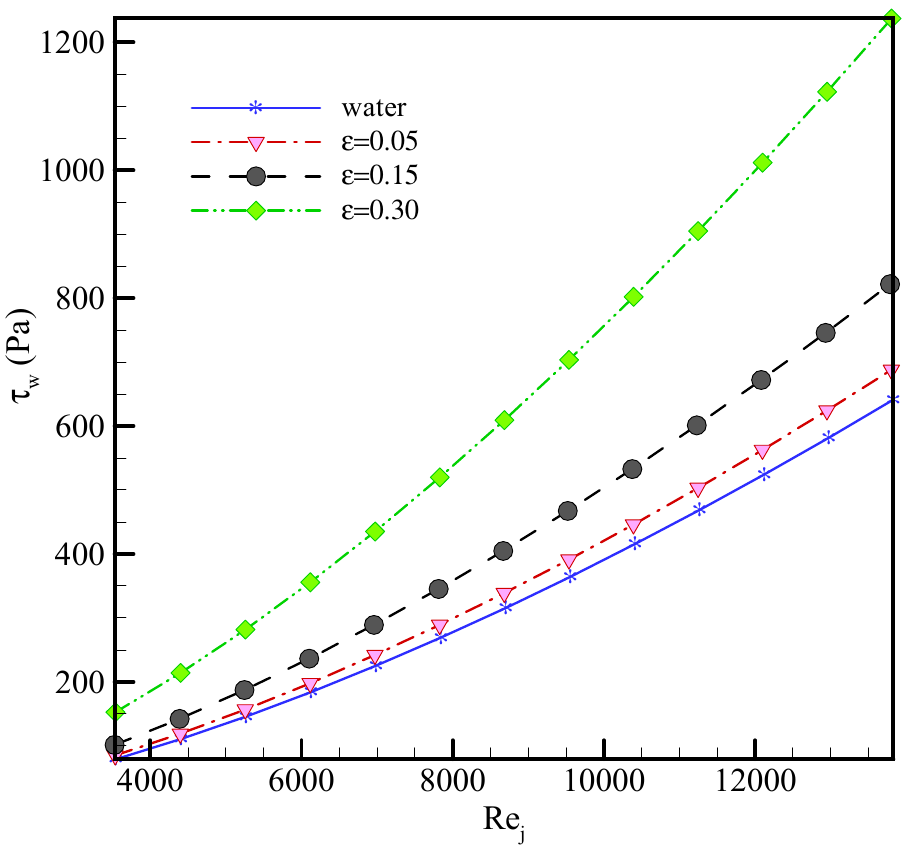
Figure 6. The effect of NEPCM concentration on the average wall shear stress of stagnation flow as function of Re number.